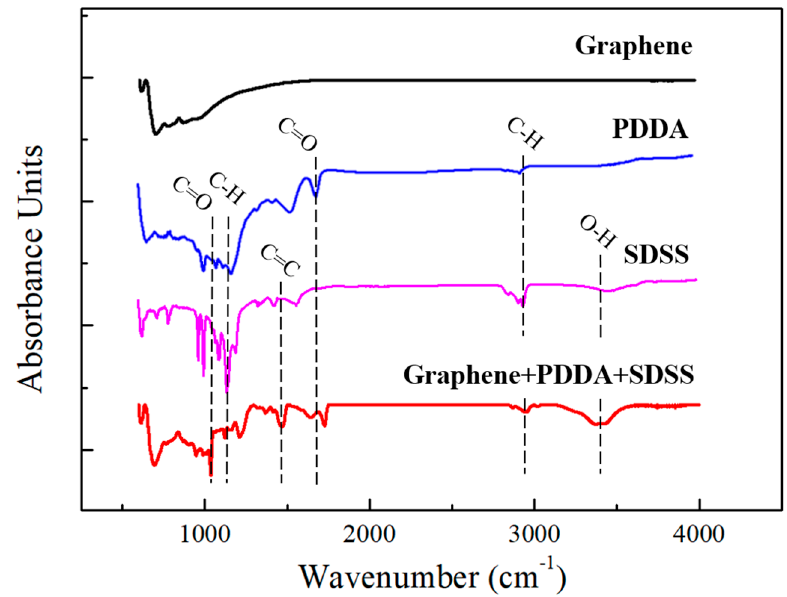
Figure 7. FTIR spectra of the intrinsic GNFs and GNFs treated with SDSS and PDDA surfactants.